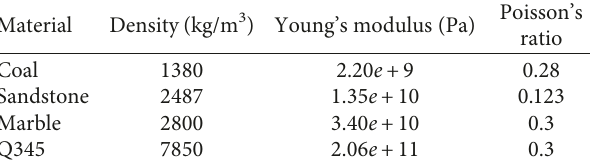
Table 4: Material parameters of coal gangue and Q345.